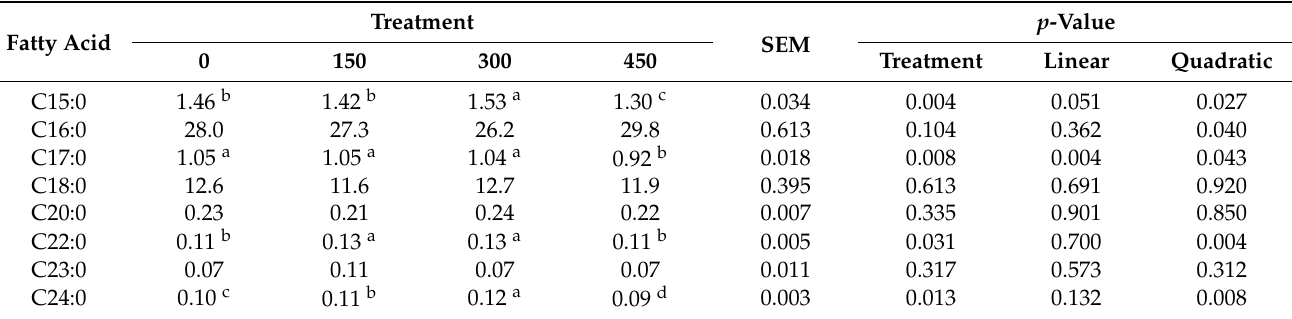
Table 1. Saturated fatty acids (g/100 g of total fatty acids) in milk from crossbred F1 dairy cows fed on tropical grasses and supplemented with different levels of concentrate (0, 150, 300 and 450 g of DM concentrate/kg of daily milk production).